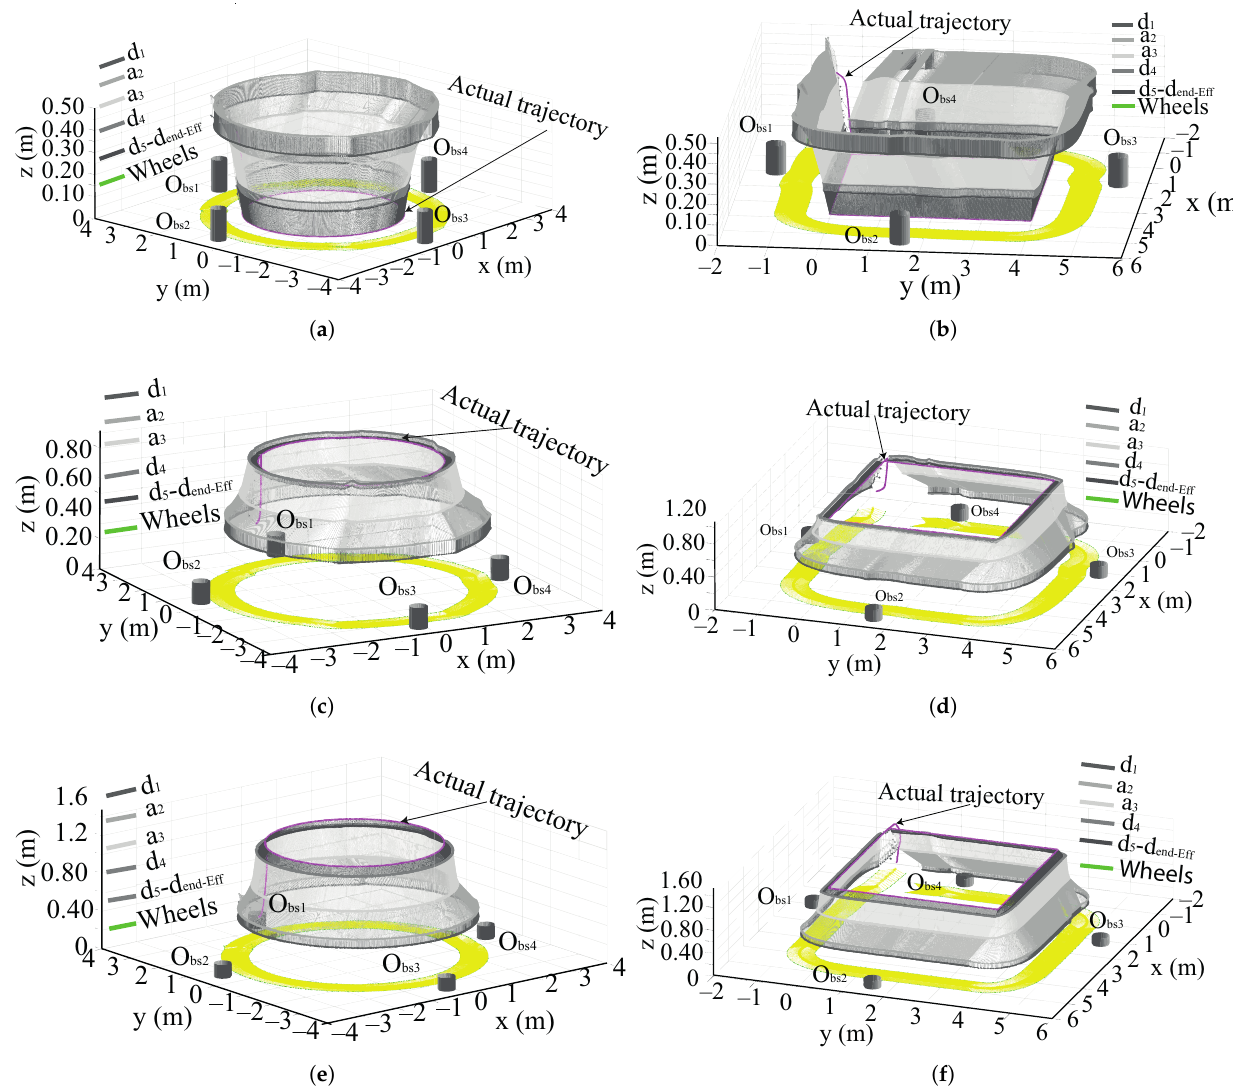
Figure 6. The solid magenta line describes the circular and square printing profiles. ( a – f ) show the tests carried out for three heights, z 1 , z 2 and z 3 for a circular profile of 2 m radius and a square profile of 2 m width and 2 m